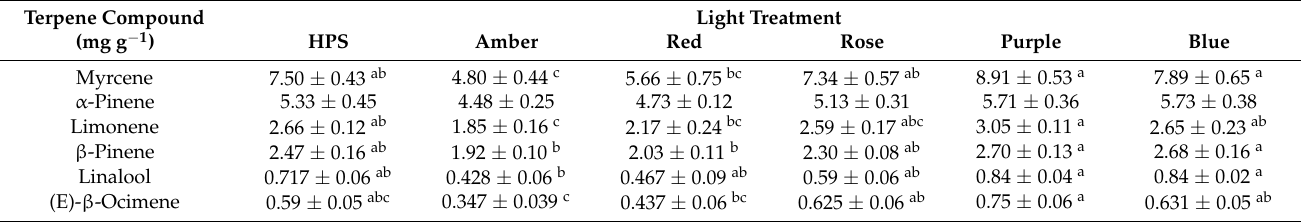
Table 4. Concentrations of the six most abundant terpene compounds in C. sativa plants cultivated under different light treatments. High-pressure sodium (HPS), Blue (430 nm), Red (630 nm), Rose (430 + 630 nm, B:R ratio 1:10), Purple (430 + 630 nm, B:R ratio 2:1), and Amber (595 nm). Bold numbers are the highest terpene for each light treatment. Each treatment had six biological replicates and values are shown as mean ± SE ( n = 6). Different letters denote significant differences ( p <